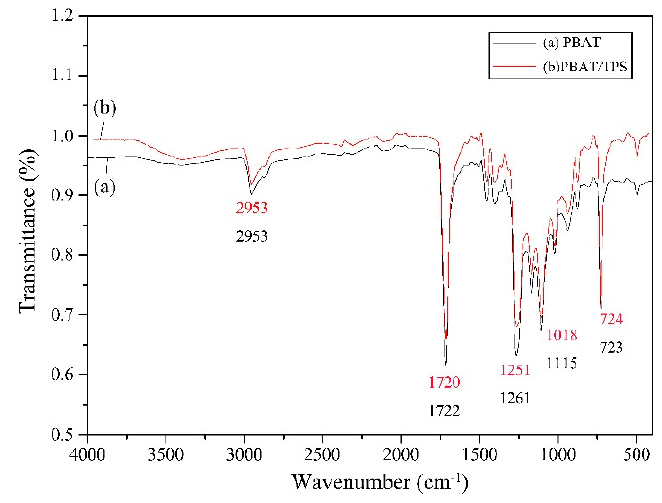
Figure 6. FTIR spectra of PBAT and 10% plasticized starch/PBAT.